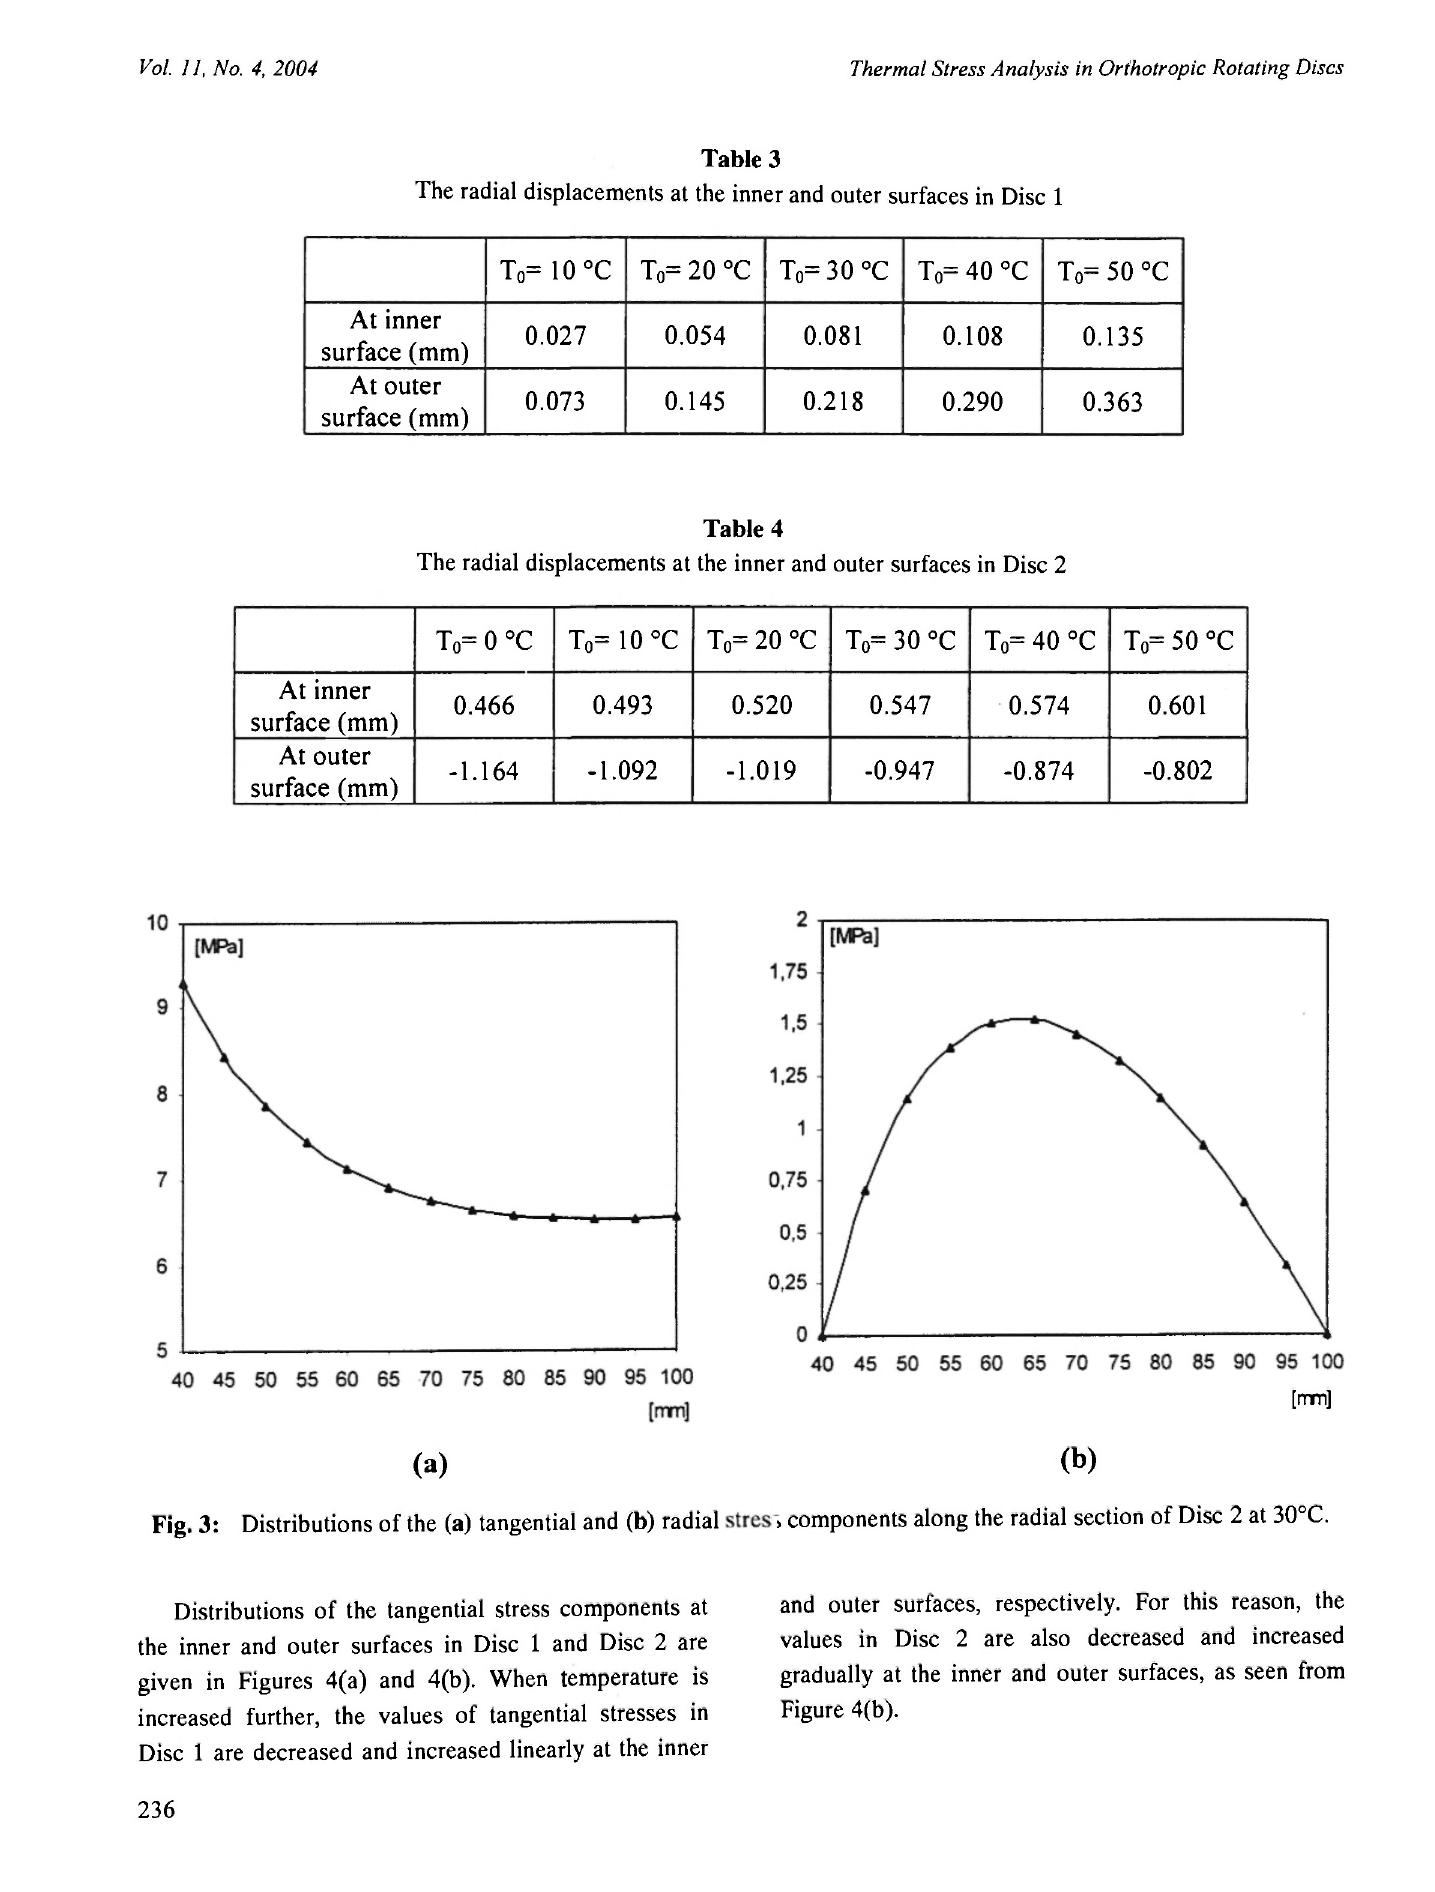
Distributions of the tangential stress components at the inner and outer surfaces in Disc 1 and Disc 2 are given in Figures 4(a) and 4(b). When temperature is increased further, the values of tangential stresses in Disc 1 are decreased and increased linearly at the inner